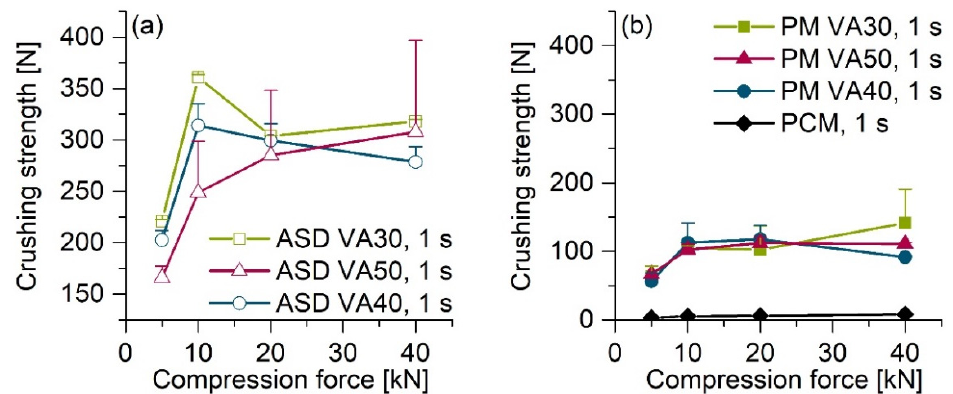
Figure 4. Crushing strengths of pure ASD and PM tablets without MCC 200 directly after preparation as a function of compression force: ( a ) pure ASD tablets compressed with a dwell time of 1 s, ( b ) pure PM and PCM tablets compressed with a dwell time of 1 s; average ± SD, n = 2. For clarity, only the upper error bars are displayed.